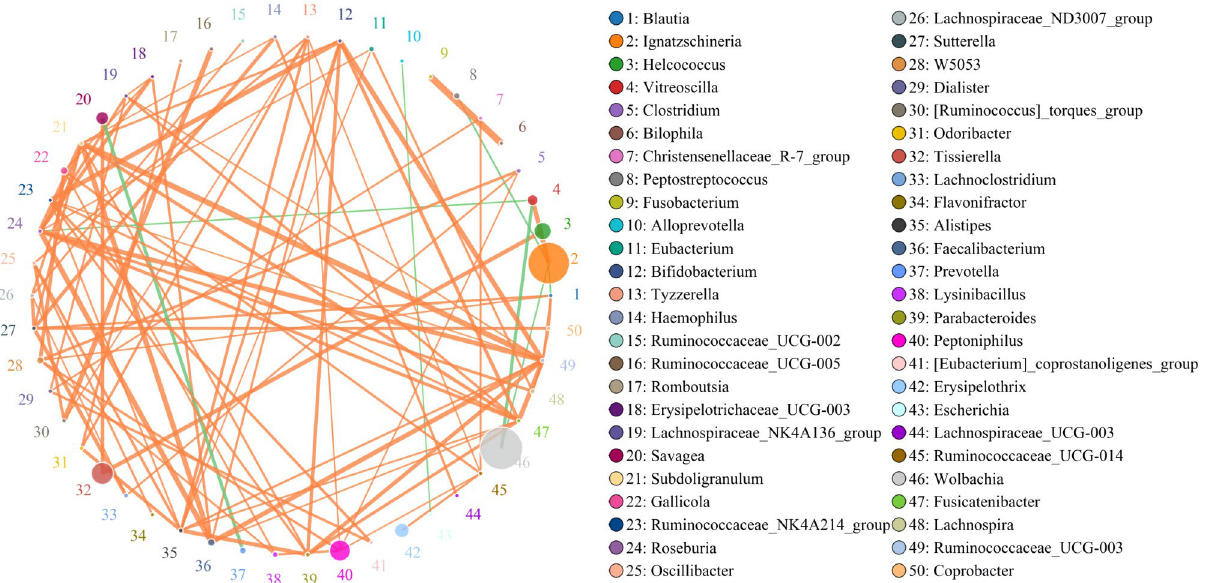
Figure 4. Bacterial networks at the genus level. Orange and green lines represent positive and negative correlations, respectively.